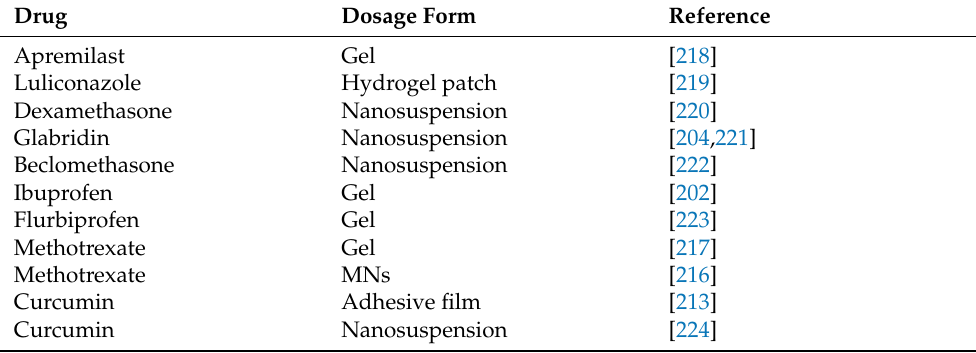
Table 3. Research efforts demonstrating the flexibility of nanocrystal incorporation into various dosage